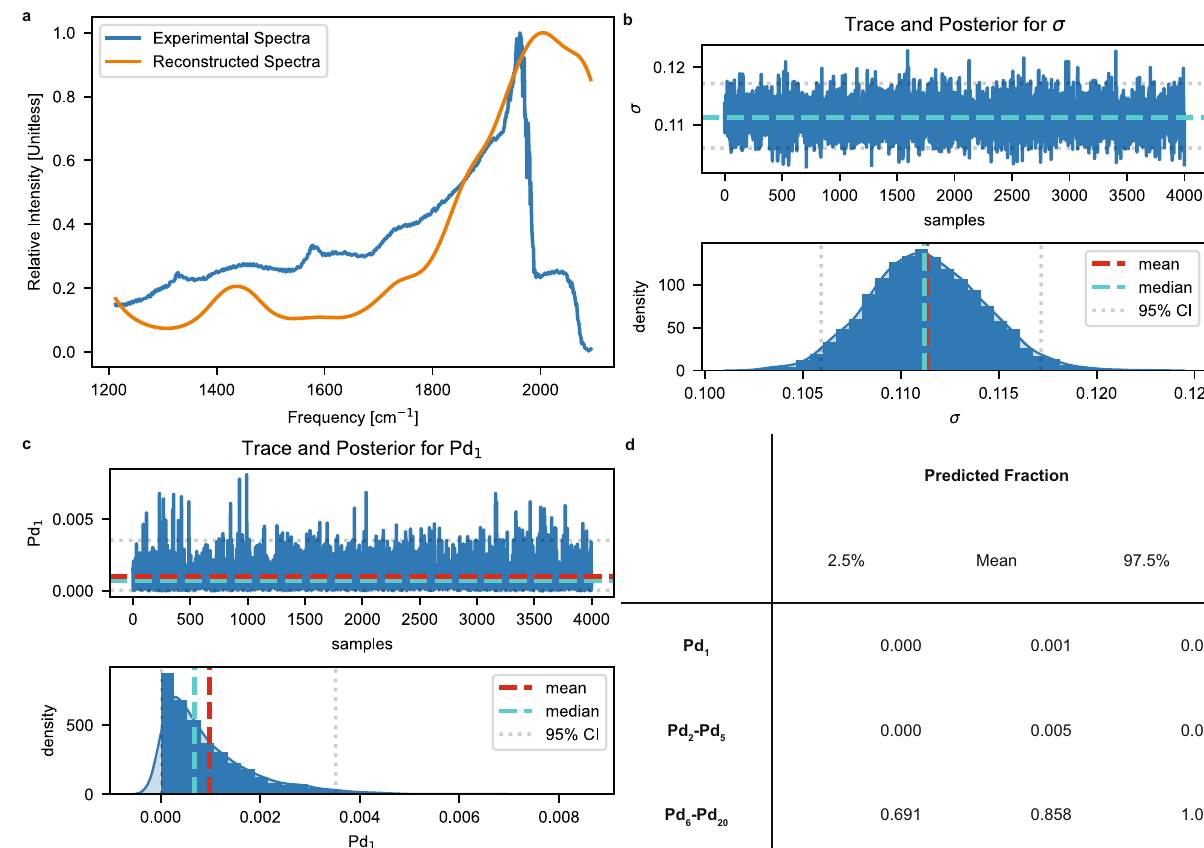
Fig.8|Experimentalspectradeconvolutionof5wt%Pd/CeO 2 systemsaturated with CO at 323K. a Discretized experimental and reconstructed spectra. b Trace andposteriordistributionfor σ ,theerrorparameter.Thespectraareequivalentfor an SNR of 80. c Trace and posterior distribution plots for Pd 1 . d Means and 95%